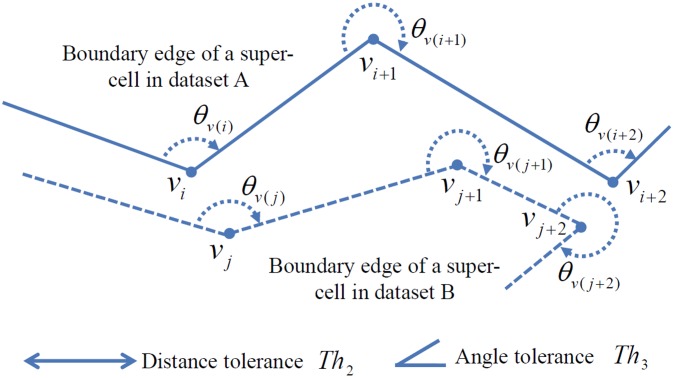
Vertex matching criteria.Vertices (v) and their interior angles (θ) of boundaries of super-cells in dataset A and B with distance and angle difference threshold.